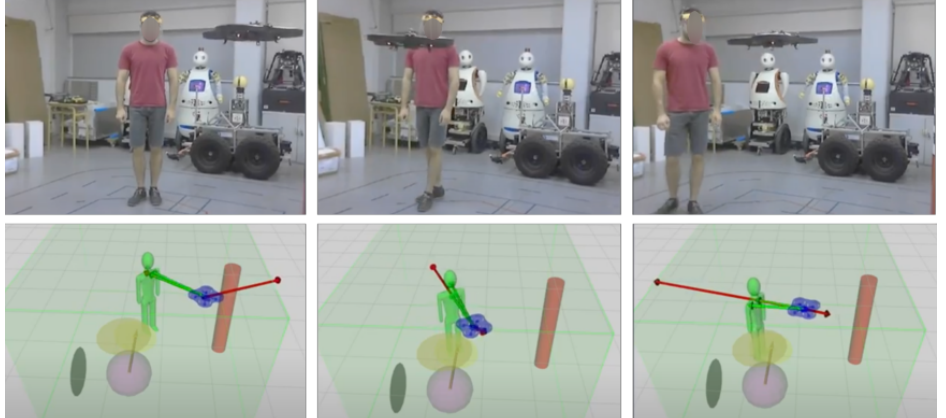
Figure 12. Real-life experiments: ( Top ): Validation of the model in a real-world environment. ( Bottom ): Gazebo simulation replicating the conditions found in the laboratory. The drone, the main human and an obstacle are the only elements in the environment, which is also limited by the green volume.